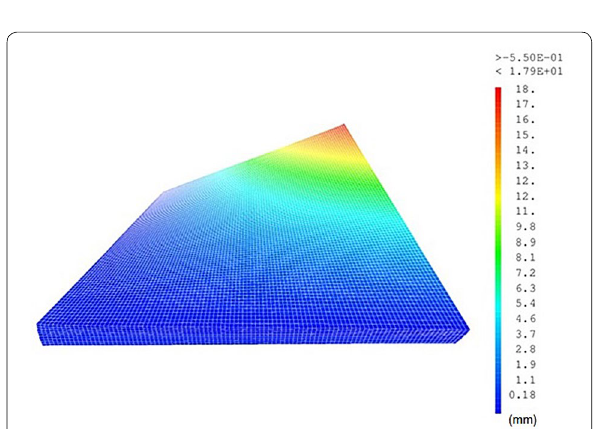
Fig. 13 Displacement field of plywood obtained numerically after 50 h of drying (scenario